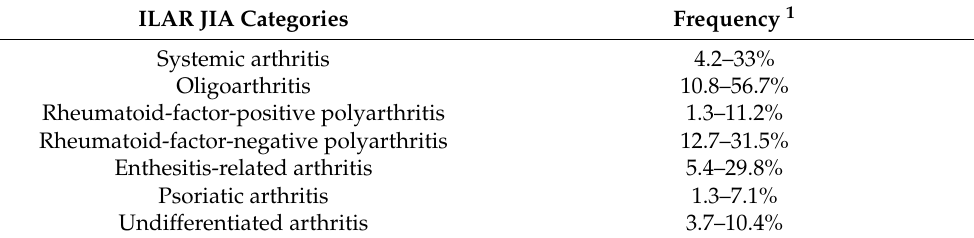
Table 1. Worldwide frequency of the ILAR categories of